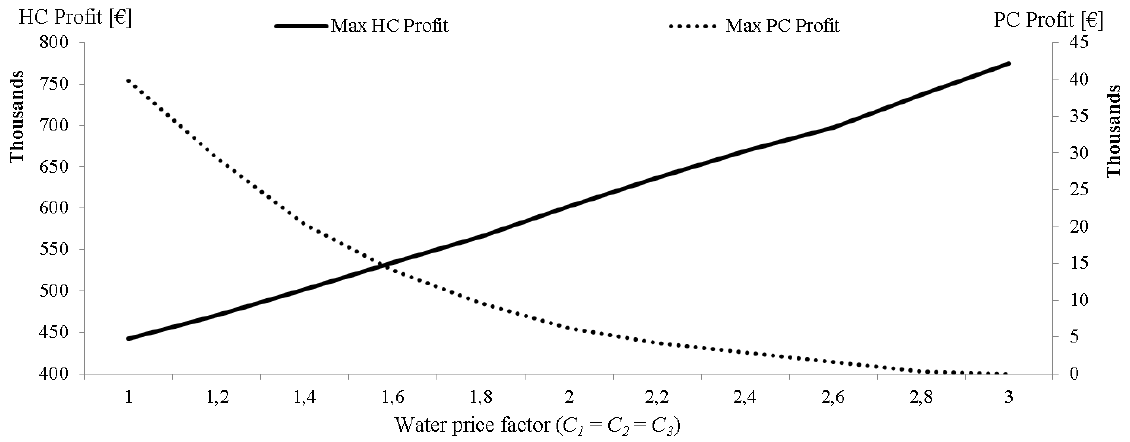
Figure 8. Water price factors impacts on PC\HC maximal